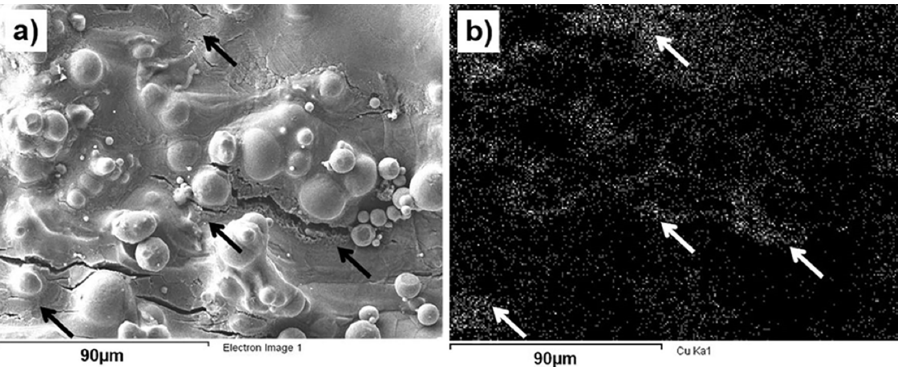
Figure 6. Fracture surface of LPBF Ti6Al4V (ELI) ‐ 1 at % Cu mini ‐ samples: ( a ) and ( b ) opposite surfaces of a cup ‐ and ‐ cone fracture; ( c ) morphology of the fracture surface in the fibrous zone; and ( d ) area of the enhanced concentration of Cu observed at a shear lip.